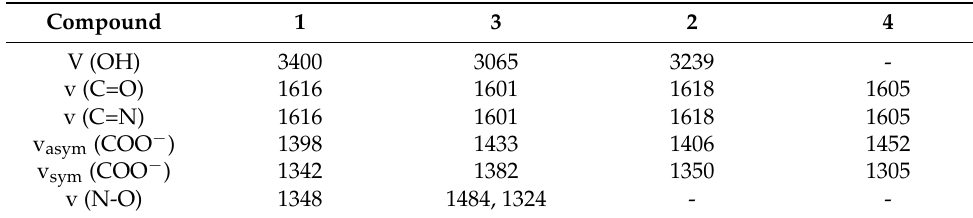
Table 2. Infrared spectral data (cm − 1 ) of Schiff base ligands and their complexes.